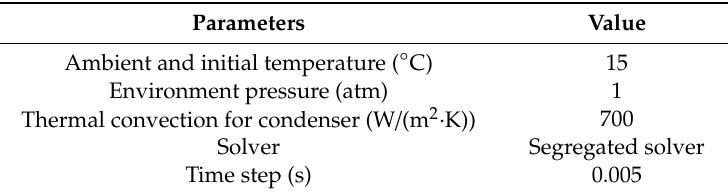
Table 2. Simulation